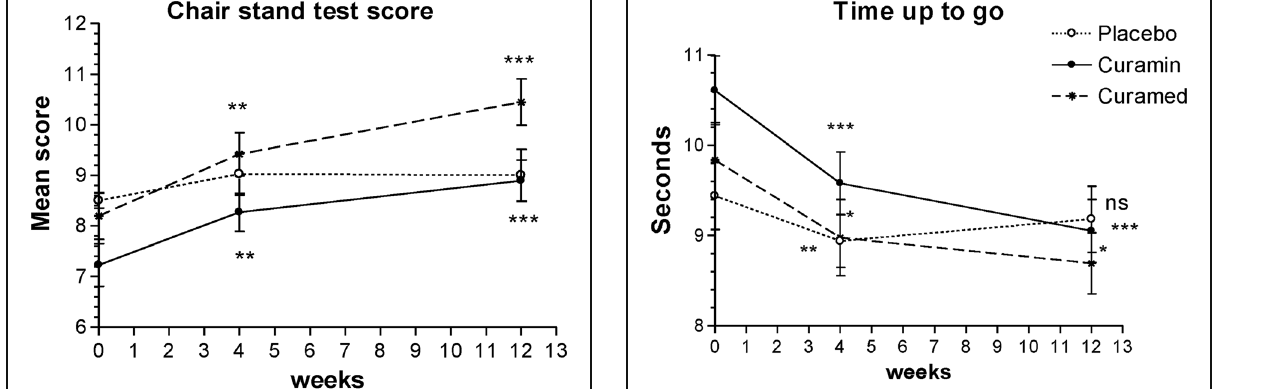
interval, − 0.756 - -0.008) and 0.447 (confidence interval, -0.826 − -0.067) vs 0.036 (confidence interval, -0.333 − 0.405) in the placebo group (Table 3).